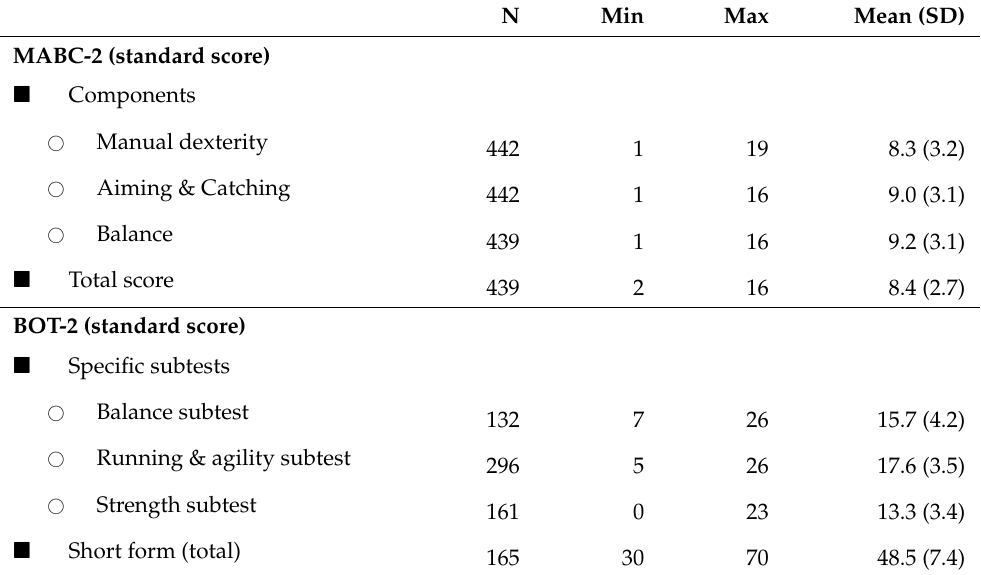
Table 2. Test scores of the sample and